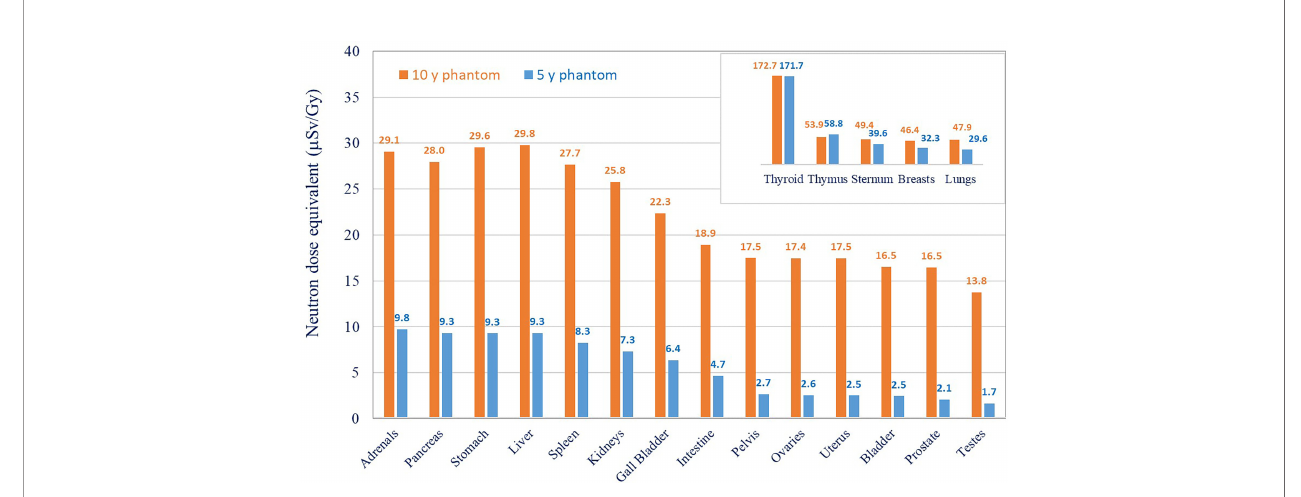
FIGURE 6 | Neutron dose equivalent in different organs for 5- and 10-year-old phantom. Results were extrapolated from data the measured with track detectors.